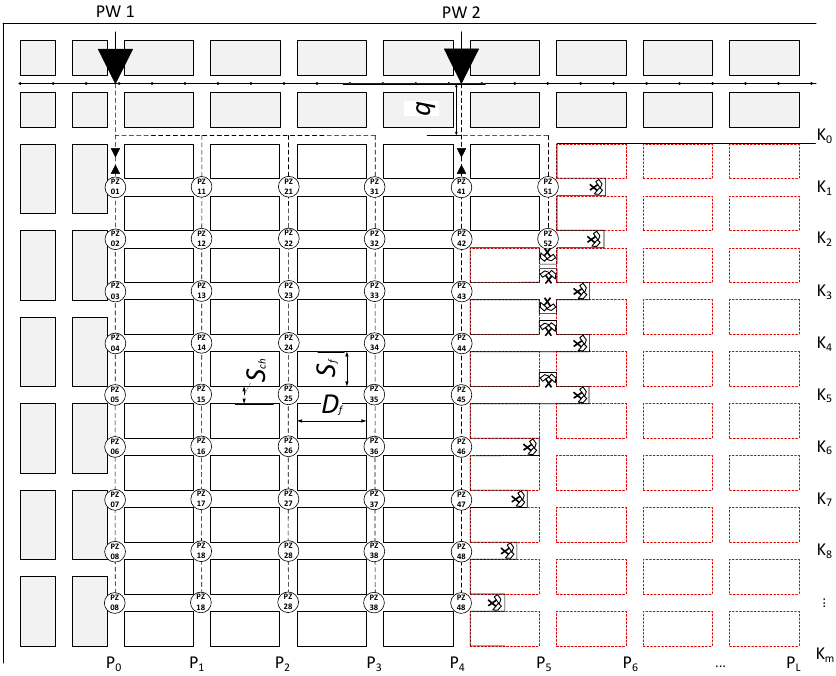
Figure 3. Characteristic dimensions of the exploitation field and a diagram of the location of the winning loading points PZ at the cross-cutting stage [24].